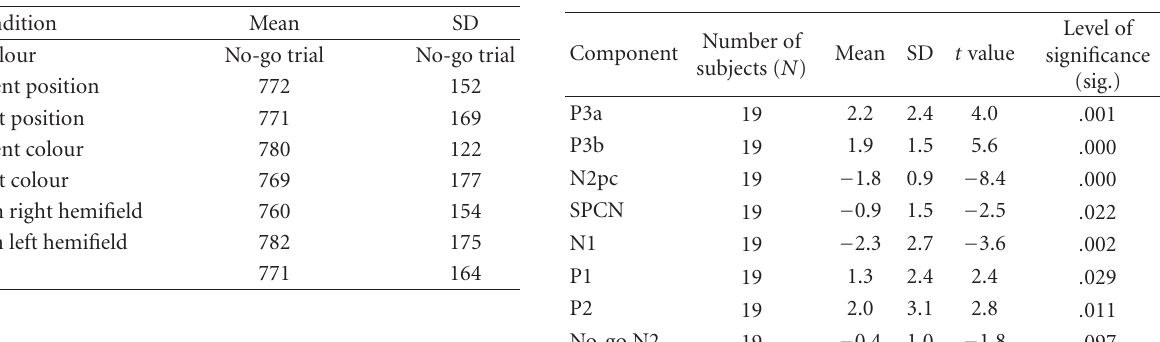
Table 4: Reaction time (ms), for each condition, for correct and incorrect trials.